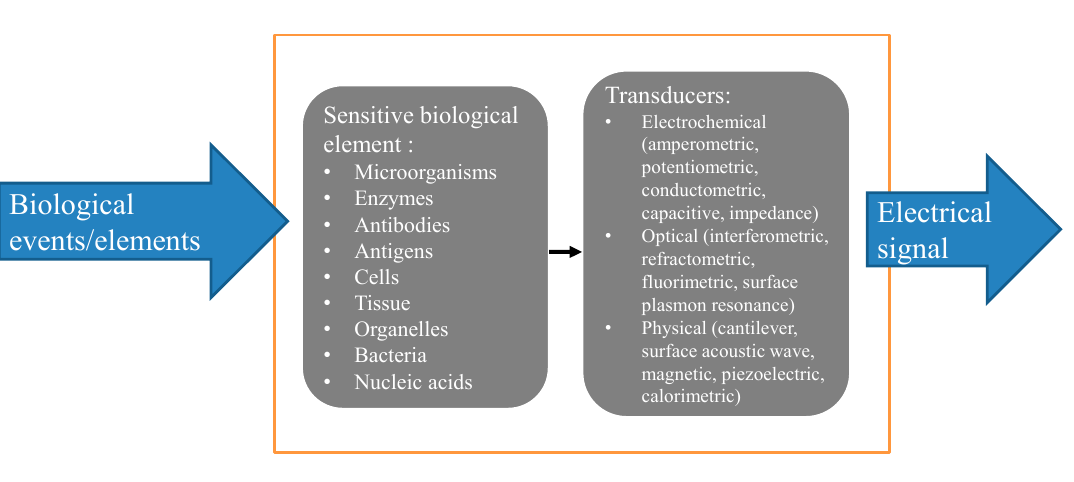
Figure 1. Principle of biosensors.